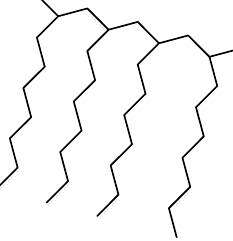
Figure 3. The possible structural formula of the poly- α -olefin (PAO).